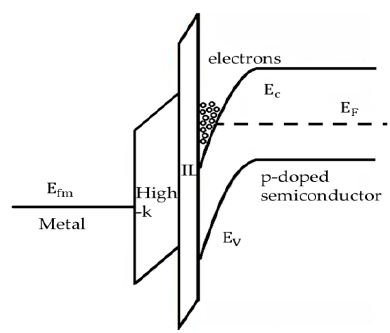
Figure 2. Band bending diagram.